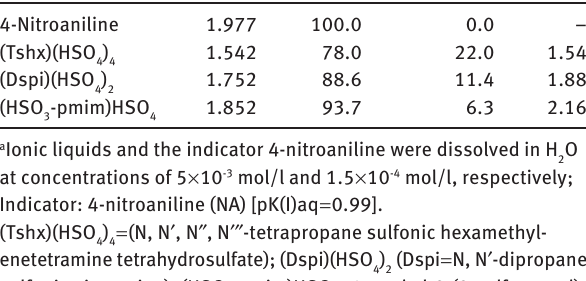
Table 1 Hammett function values of various acidic ionic liquids a . Ionic